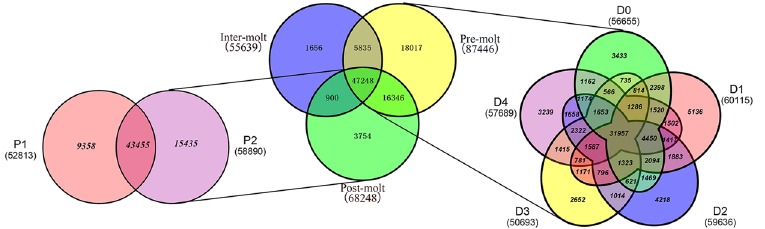
Figure 3. A venn diagram showing the genes expressed in three major stages (inter-moult, pre-moult and post- most) of the moulting process. The details of expressed gene among eight moulting stages are shown.